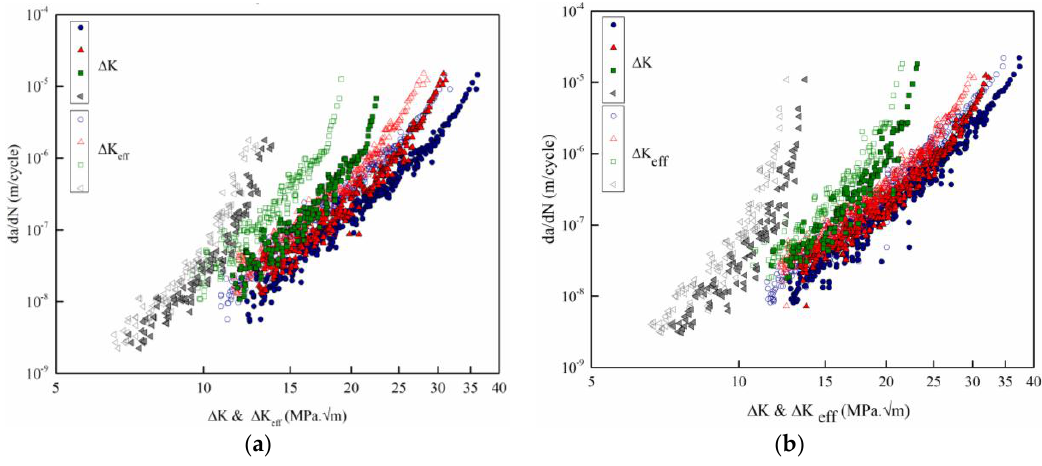
Figure 8. Fatigue crack growth rates of ( a ) admixed and ( b ) pre-alloyed PM steels versus ∆ K and ∆ K eff .